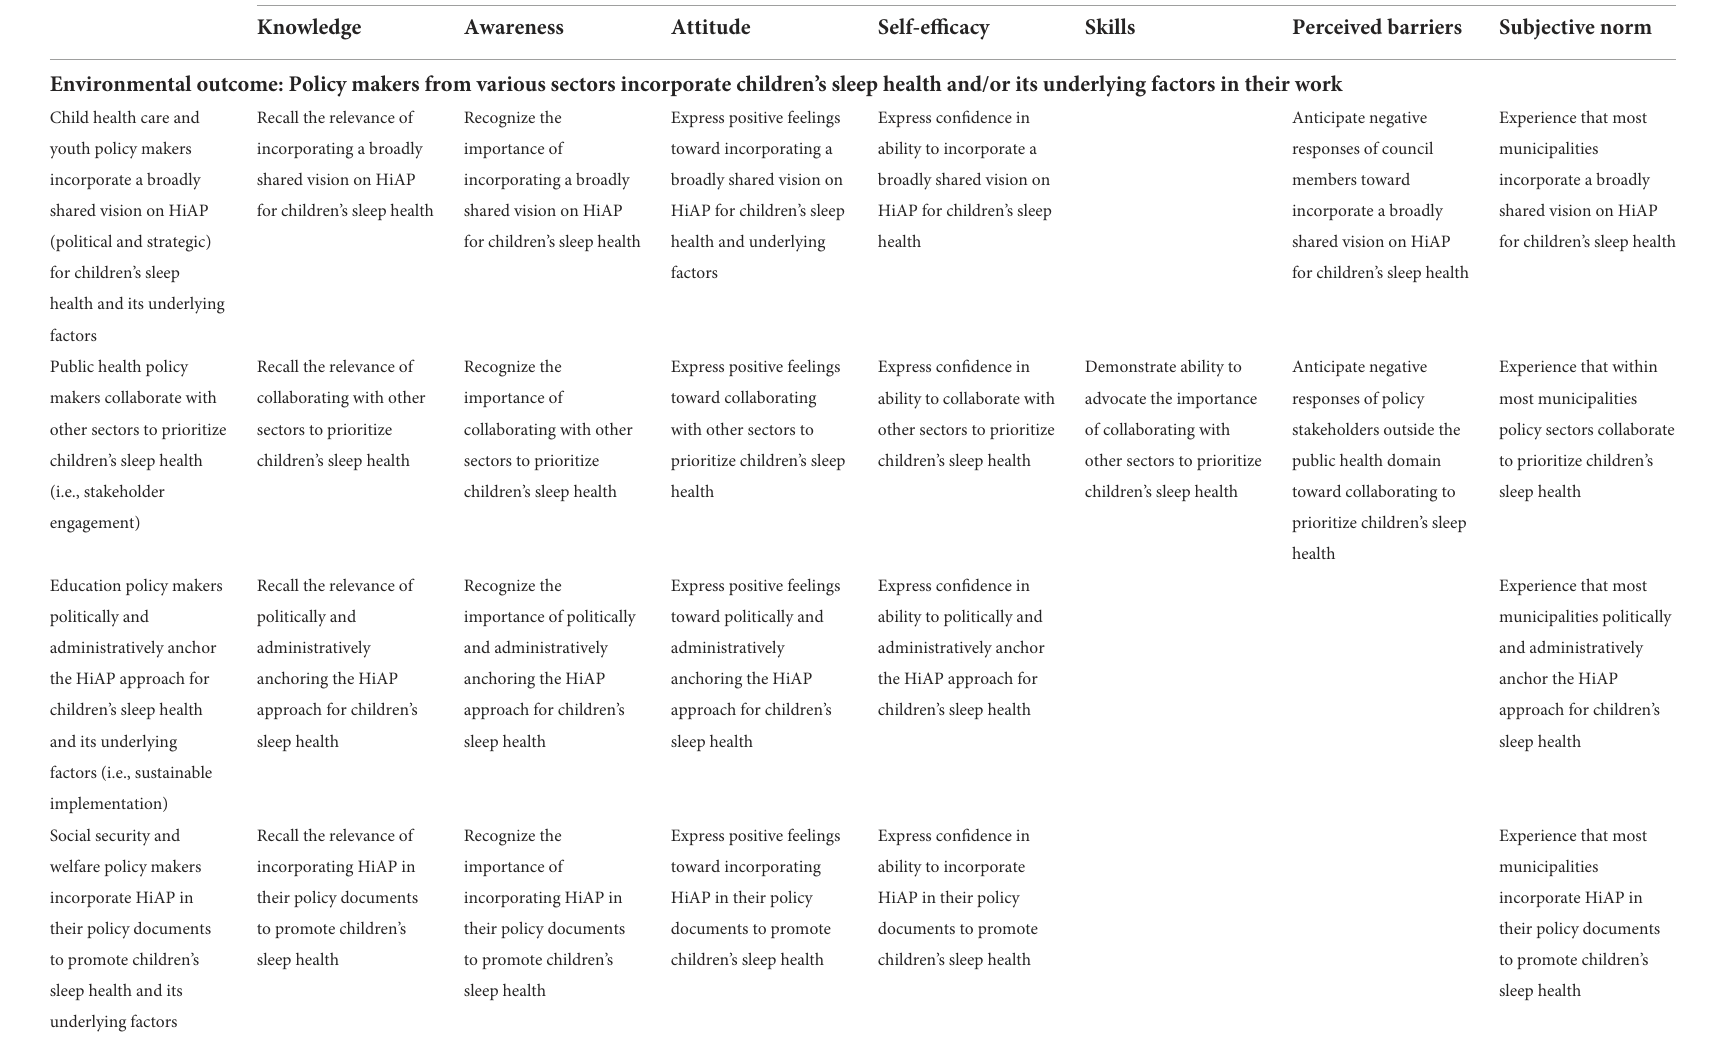
TABLE 2 Examples of performance and change objectives for policy